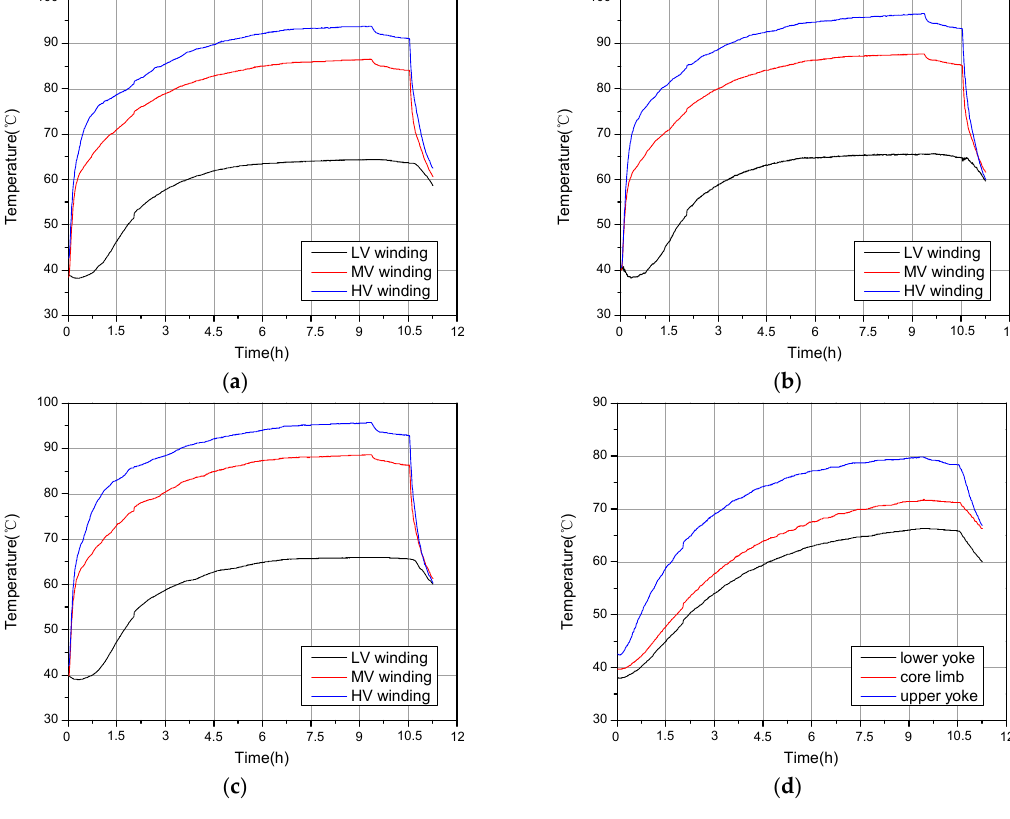
Figure 9. ( a ) Temperature of A phase windings; ( b ) Temperature of B phase windings; ( c ) Temperature of C phase windings and ( d ) Temperature of iron core.